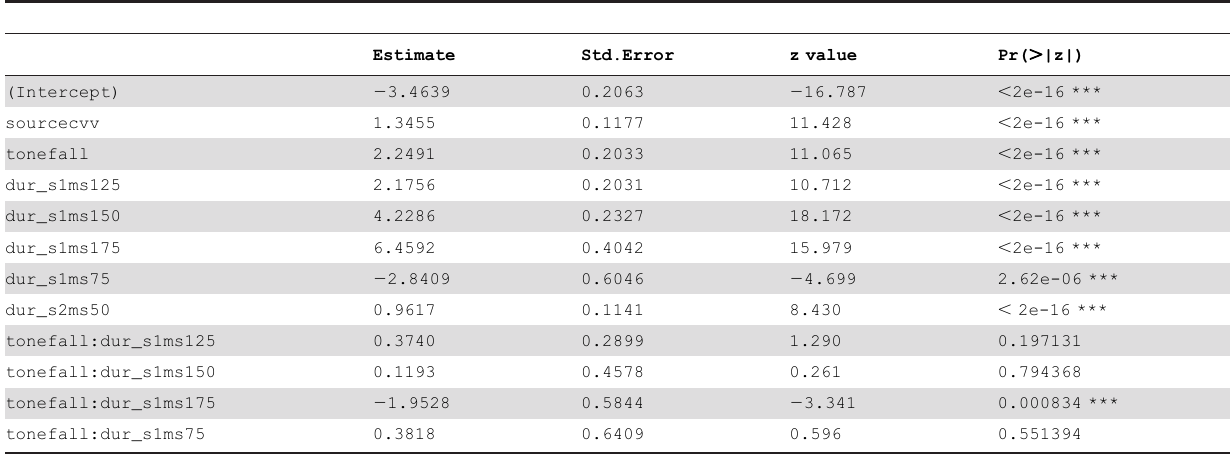
Table 1. Summary of results from the logistic regression analyses for Experiment 1 for the model with the best fit.